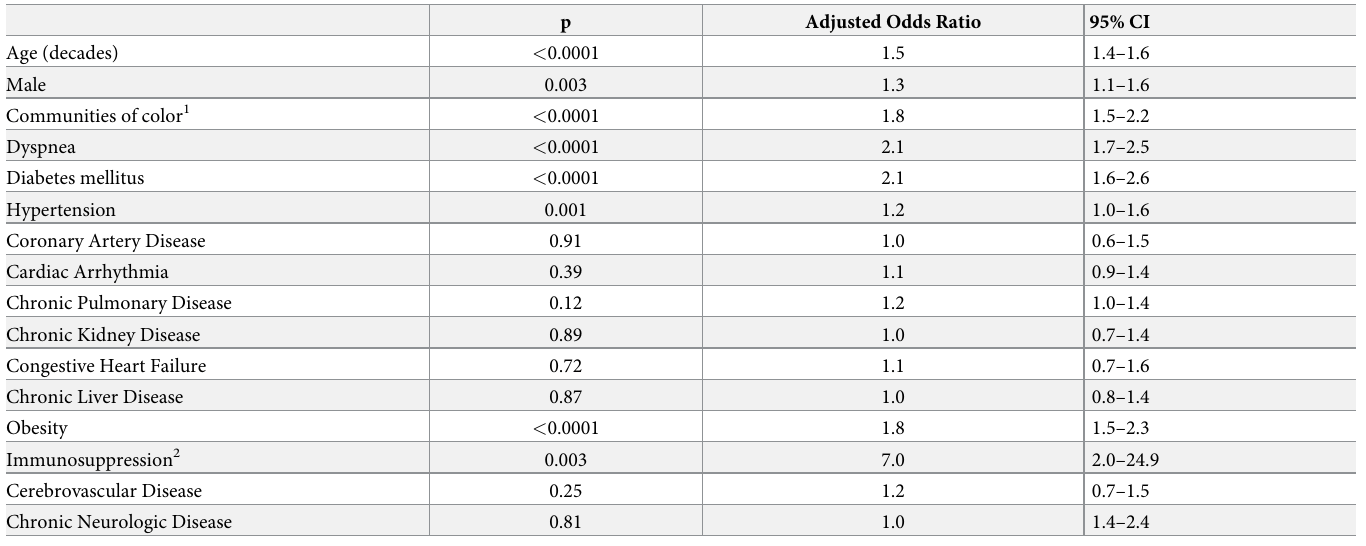
Table 5. Sensitivity Analysis: Multivariable logistic regression model for hospitalization in the derivation cohort, excluding patients admitted from the emergency department.